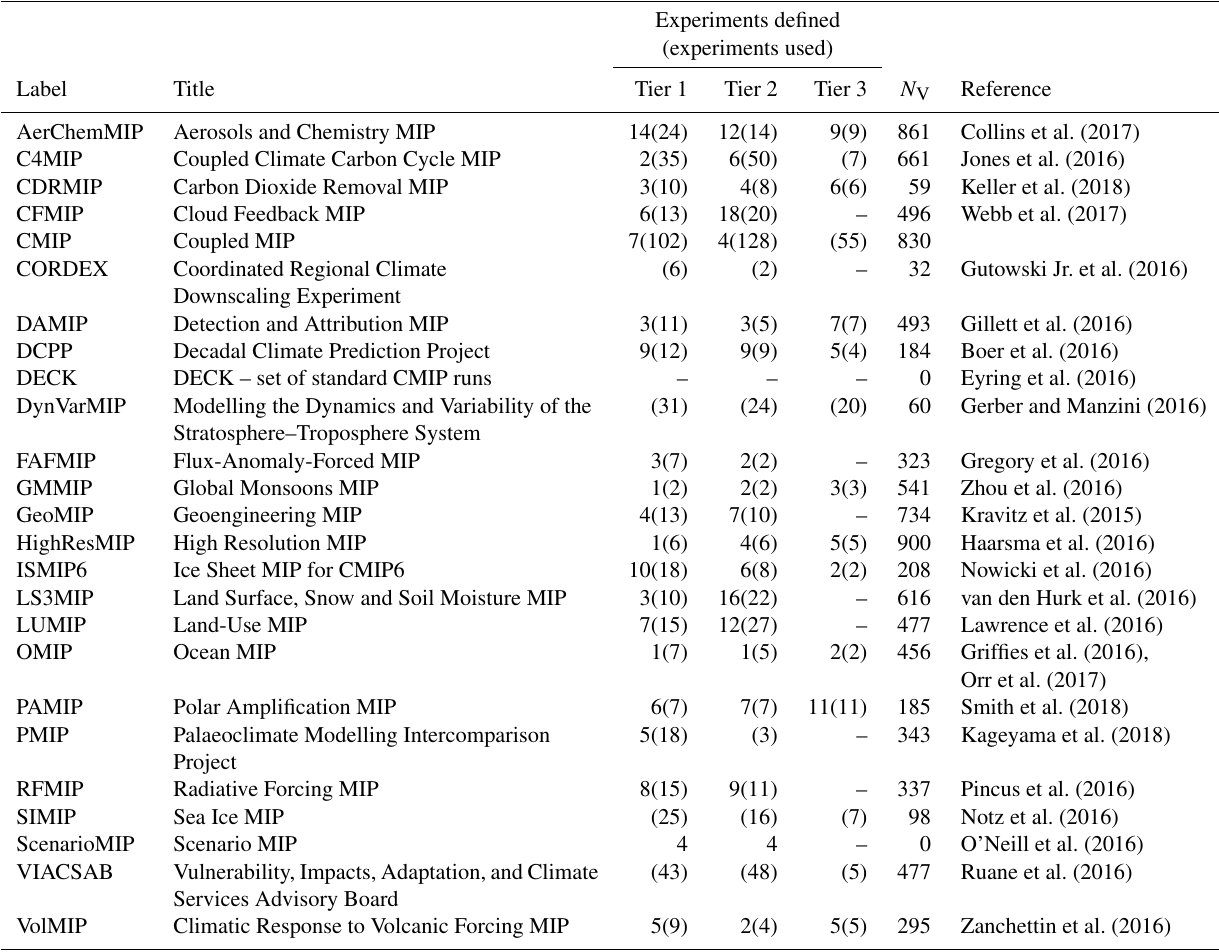
Table B1. Labels used for collections of experiments in the DREQ and the number of experiments and variables in each collection. N V : the number of variables requested by each MIP. “Experiments defined” refers to experiments that have been designed by that MIP. “experiments used” refers to experiments that they are requesting data from (numbers entered in brackets). For example, SIMIP is a diagnostic MIP, which means that they have not defined any experiments but they are requesting data from (i.e. using) experiments defined by others. Experiments